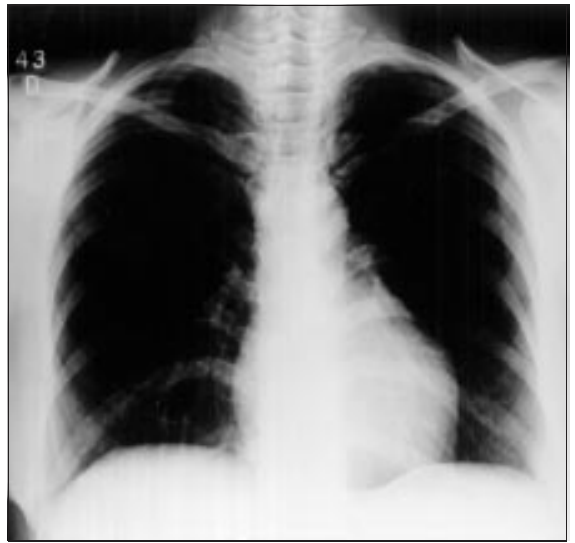
Fig. 1 – Radiografia de tórax em PA no pré-operatório mostrando abaulamento da silhueta cardíaca esquerda.